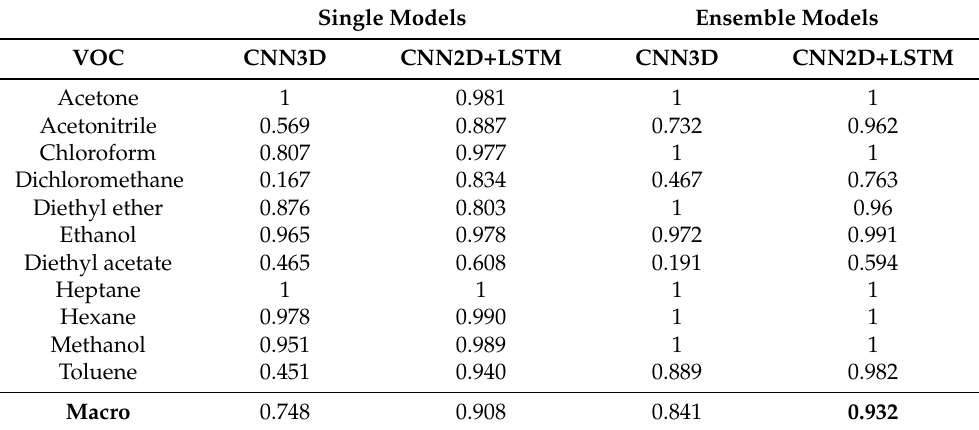
Table 4. VOC recognition F1-score on test set. The best macro F1-score is shown in bold.